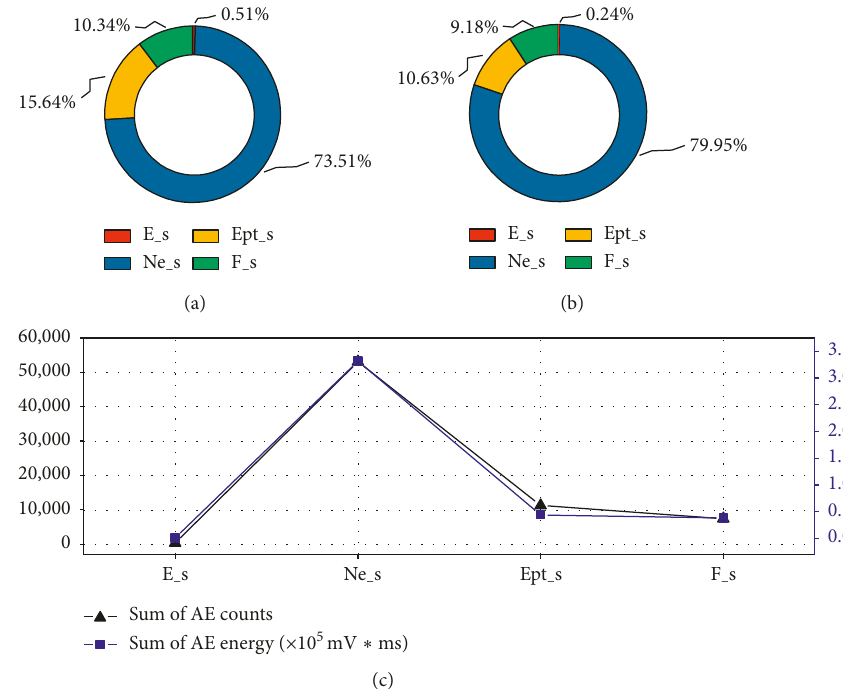
Figure 14: Trends of AE event counts and energy counts of C40 concrete blocks and their respective percentages: (a) percentage of AE event counts to total counts; (b) percentage of AE energy counts to total counts; (c) trends in AE event counts and energy counts. E_s: elastic stage; Ne_s: nonlinear elastic stage; Ept_s: transfer to expansion pressure stage; F_s: fracturing stage.